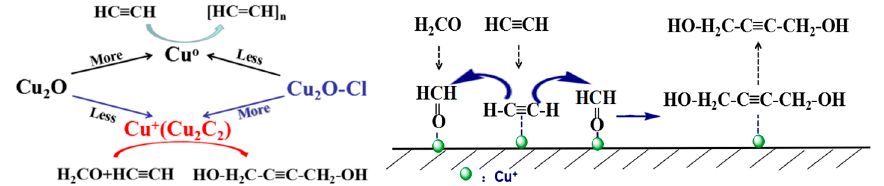
Figure 13. A scheme of Cu 2 O phase transformation and a plausible reaction mechanism.